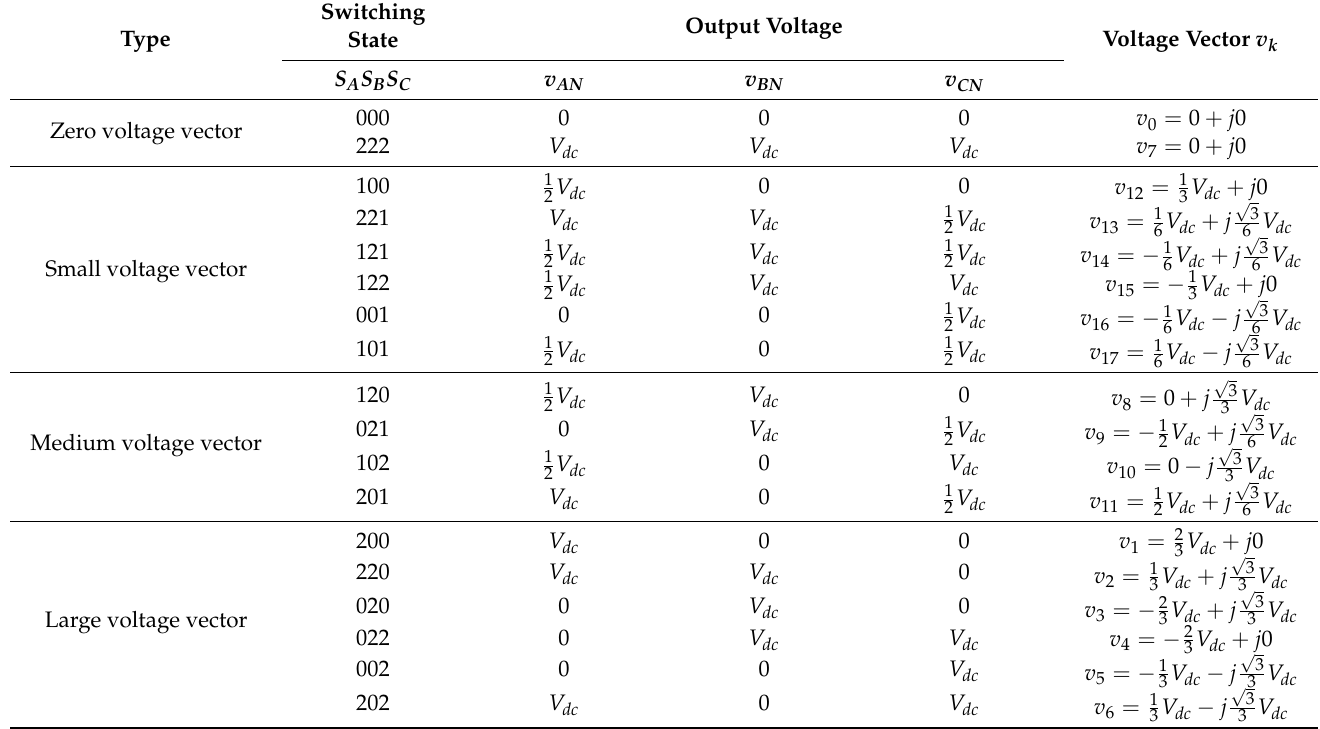
Table 2. Switching states and output voltage vectors for proposed inverter.